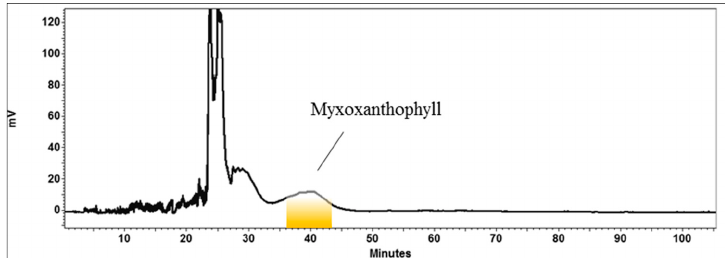
Figure 3. High performance countercurrent chromatography (HPCCC) separation of myxoxanthophyll from Synechocystis salina ( S. salina ) extract. Biphasic solvent system: System 7 ( n -Hep:EtOH:H 2 O, 2:4:4, v / v / v ). Elution mode: Reverse, the mobile phase is the lower phase of the biphasic solvent system 7. Loading per injection: 70 mg of S. salina extract. Column rotational speed: 1400 rpm. Flow rate of mobile phase: 4 mL/min. Temperature: 28 °C. Detection: 478 nm.